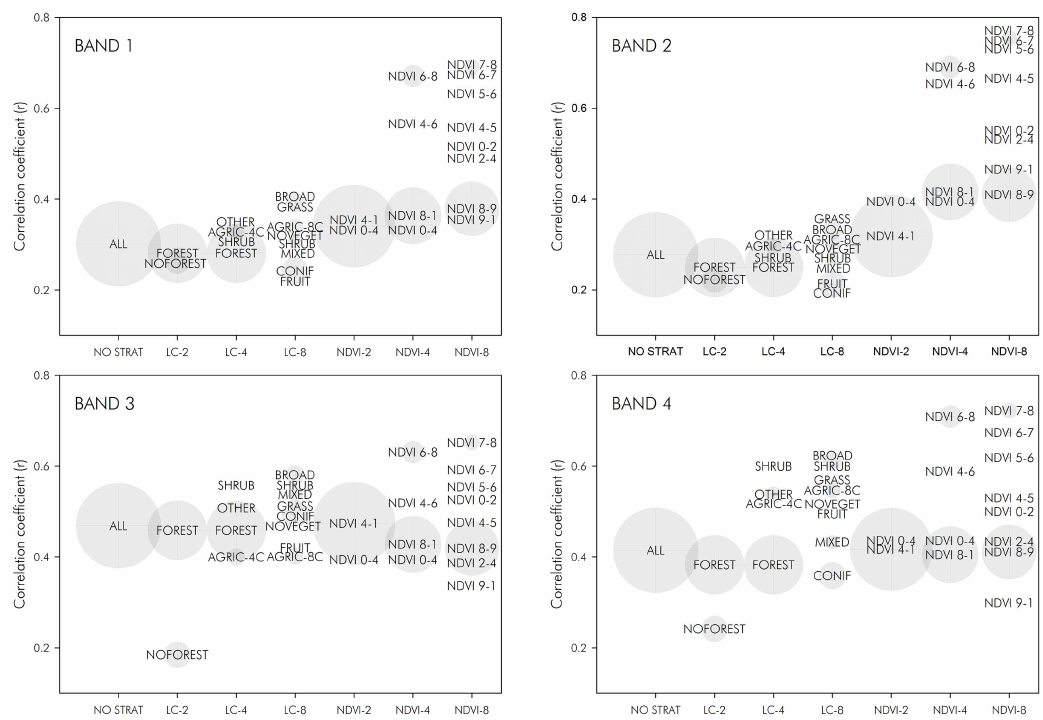
Figure 4. Correlation coefficient between cos γ i and the reflectance of spectral bands for each stratum. Circle sizes represent the proportion of each stratum in the study area.